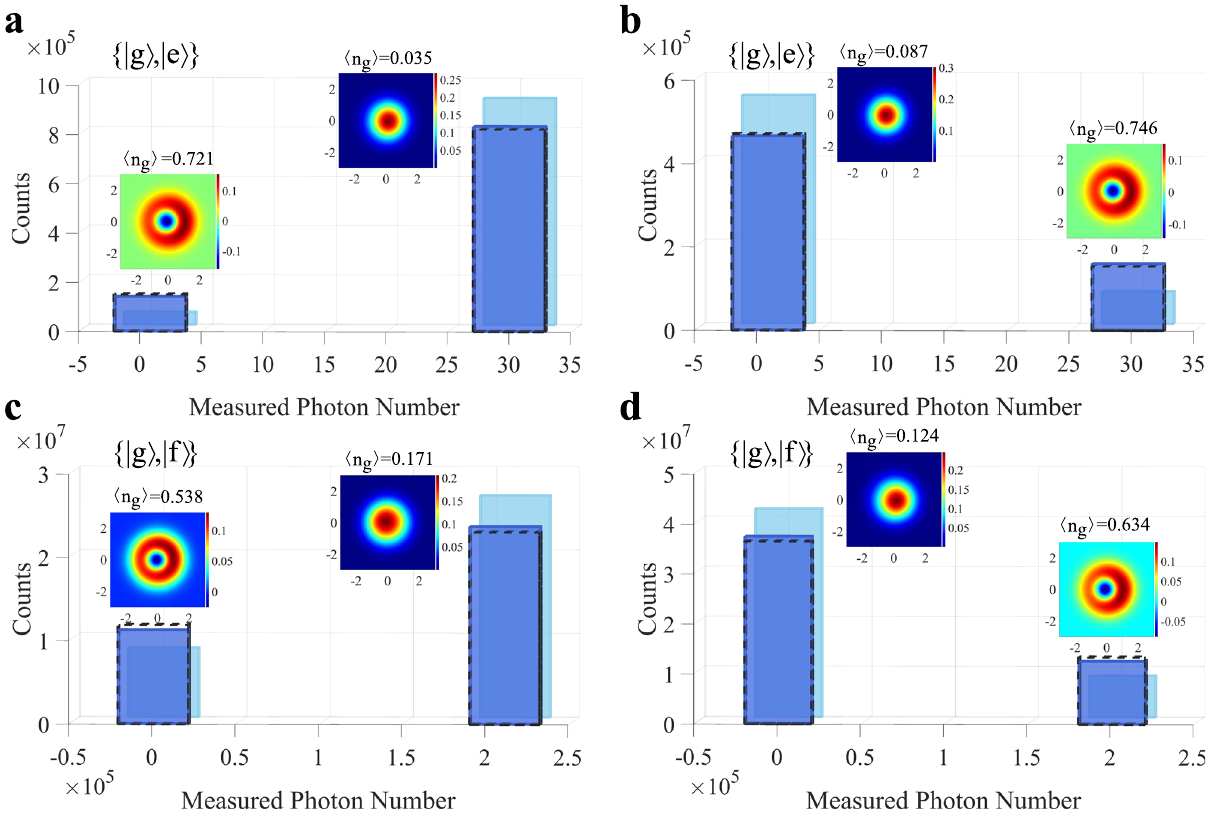
Fig.2|Single-photonswitch. WeuseaGaussian-shapedphotonpulseintheweak insets are the reconstructed Wigner function of the gate photons re fl ected from cavity I, conditioned on the weak or strong transmission, respectively. The Wigner coherentstatewithanaveragephotonnumber n g =0.18togatethetransistor.The frequency of the signal photon is aligned to the resonance frequency of cavity II function of the gate photons conditioned on a weak transmission resembles a (cid:1) when the qubit is in either ∣ e i or ∣ f . a presents statistical results for the "on''/"off'' vacuum state, whereas for a strong transmission, the measured Wigner function is states of the transistor with an average signal photon number n s = 37.2 and qubit similar to a single-photon Fock state. The conditional average photon number is listed. b shows similar experimental results with n s = 37.2 and θ = π , where the phase θ =0.Thedifferencebetweenthestatisticsforthetransistorstatewith(dark blue bars) and without (light blue bars) gate photons demonstrates a successful transistor is working as normally closed. The experimental results when using an switchbytherandomlyarrivedsinglegatephoton.Thereasonthatthedifferenceis ultra-strong signal strength with n s = 2.62×10 5 are shown in ( c ) and ( d ), with θ =0 and θ = π , correspondingly. Both the gate photon number and the signal photon relatively small is mainly due to the low photon number in the gate pulse, thus the number are calibrated based on the AC stark shift induced dephasing of the transistor can not be effectively switched off. The dotted bars show the corre- transmon qubit. Details about this calibration can be found in Supplemen- sponding theoretical results (see Supplementary Note 6B for details). The x-axis tary Note position for the bars gives the average output photon number for each case. The